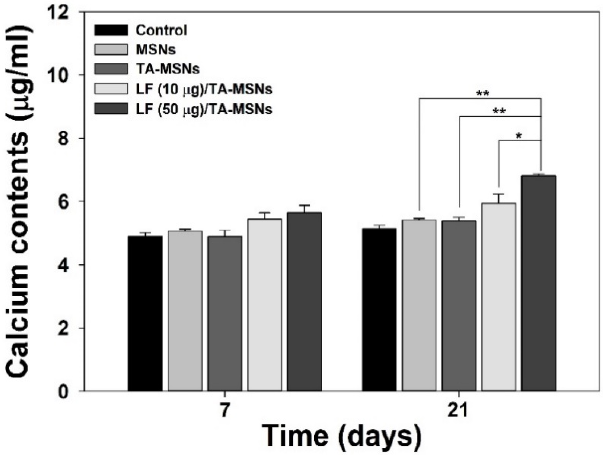
Figure 5. Calcium accumulation in adipose-derived stem cells (ADSCs) cultured with bare MSNs, TA-MSNs, LF (10 μ g)/TA-MSNs, or LF (50 μ g)/TA-MSNs after 7 and 21 days of incubation (n = 4 per group). * p < 0.05 and ** p < 0.01.